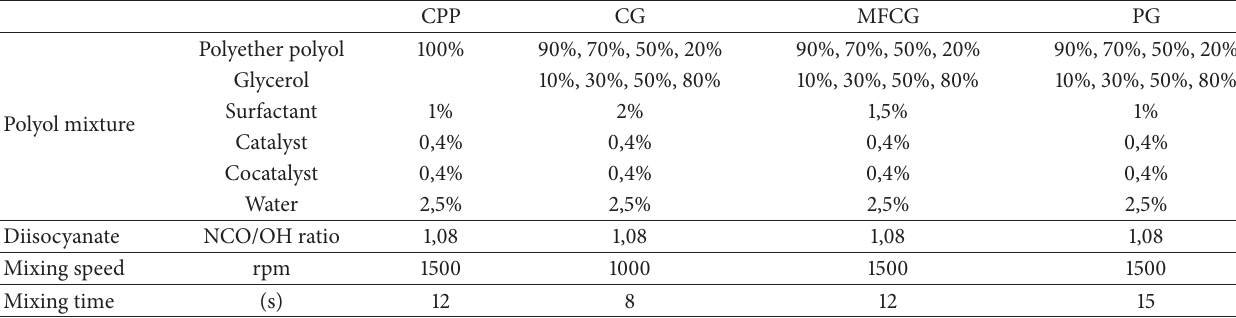
Table 1: Preparation amounts of PUF